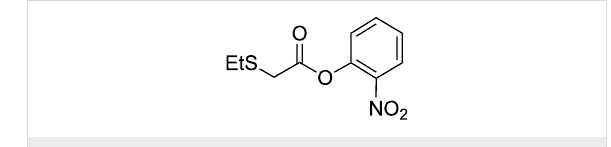
Figure 5: Predicted leaving group p K aH values required for user- defined conversion levels of starting concentrations of 0.05 M 2- S -(5 ′ - thiophosphoryluridine)acetic acid ester 7 and 0.055 M D-glucosamine to D-glucosamine amide 6 based on Brønsted extrapolations of k 0 , k OH and k NH2 . In each case, the calculations proceed to 99% consumption of ester. Squares correspond to % ester converted to amide in relation to p K aH (left hand scale); circles correspond to time taken to attain 99% consumption of the ester with a leaving group of a given p K aH .